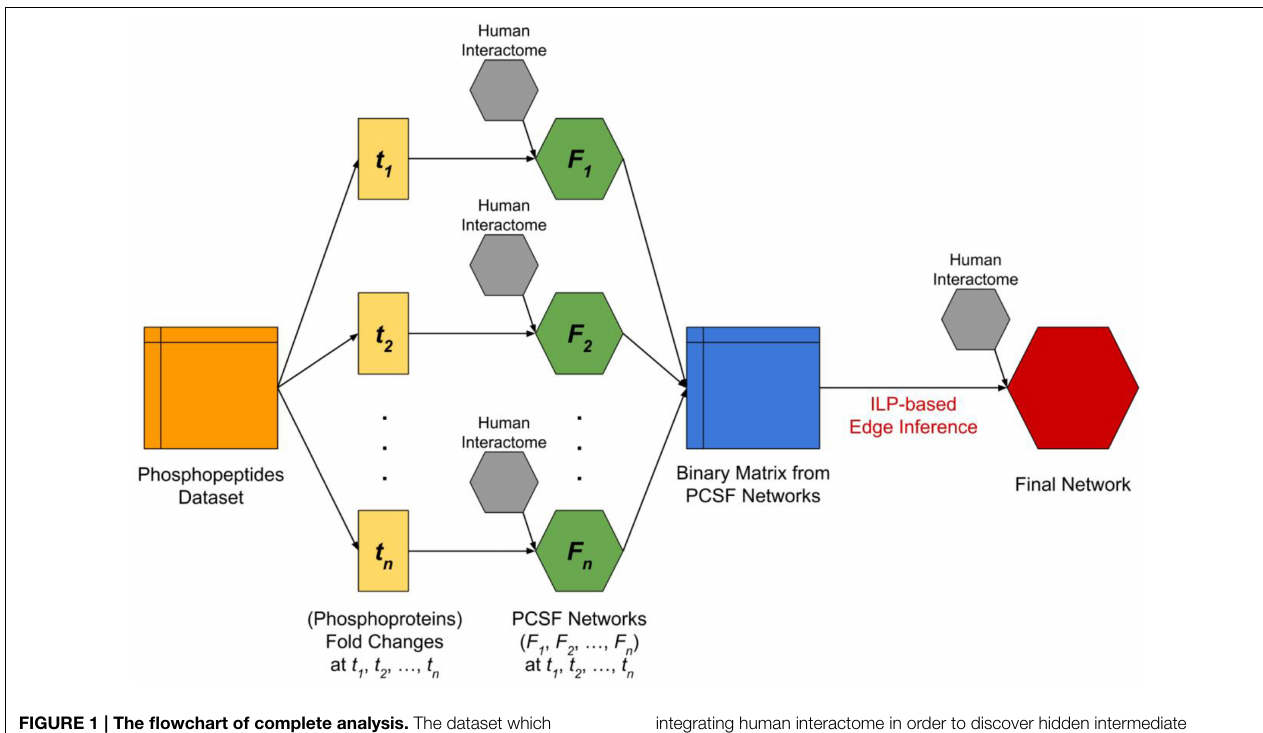
integrating human interactome in order to discover hidden intermediate proteins. The resulting networks ( F 1 , F 2 , F 3 , F 4 ) are then used to form a binary matrix where the rows are time points and columns are phosphoproteins. Each corresponding cell of the binary matrix represents a significant change ( p < 0 . 05 and variance < 15%) in the phosphoprotein at the time point. Finally, we applied an ILP-based edge inference approach by integrating human interactome in order to validate and determine edges and edge